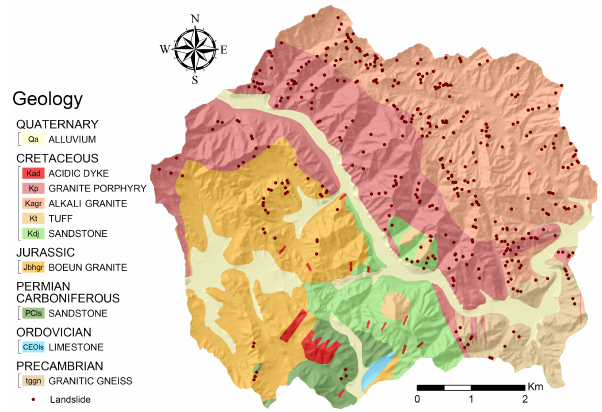
Figure 10. Geological map and location of